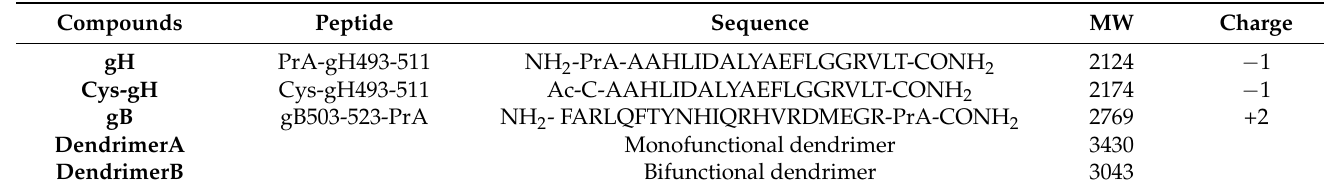
Table 1. Peptide Sequences and dendrimer